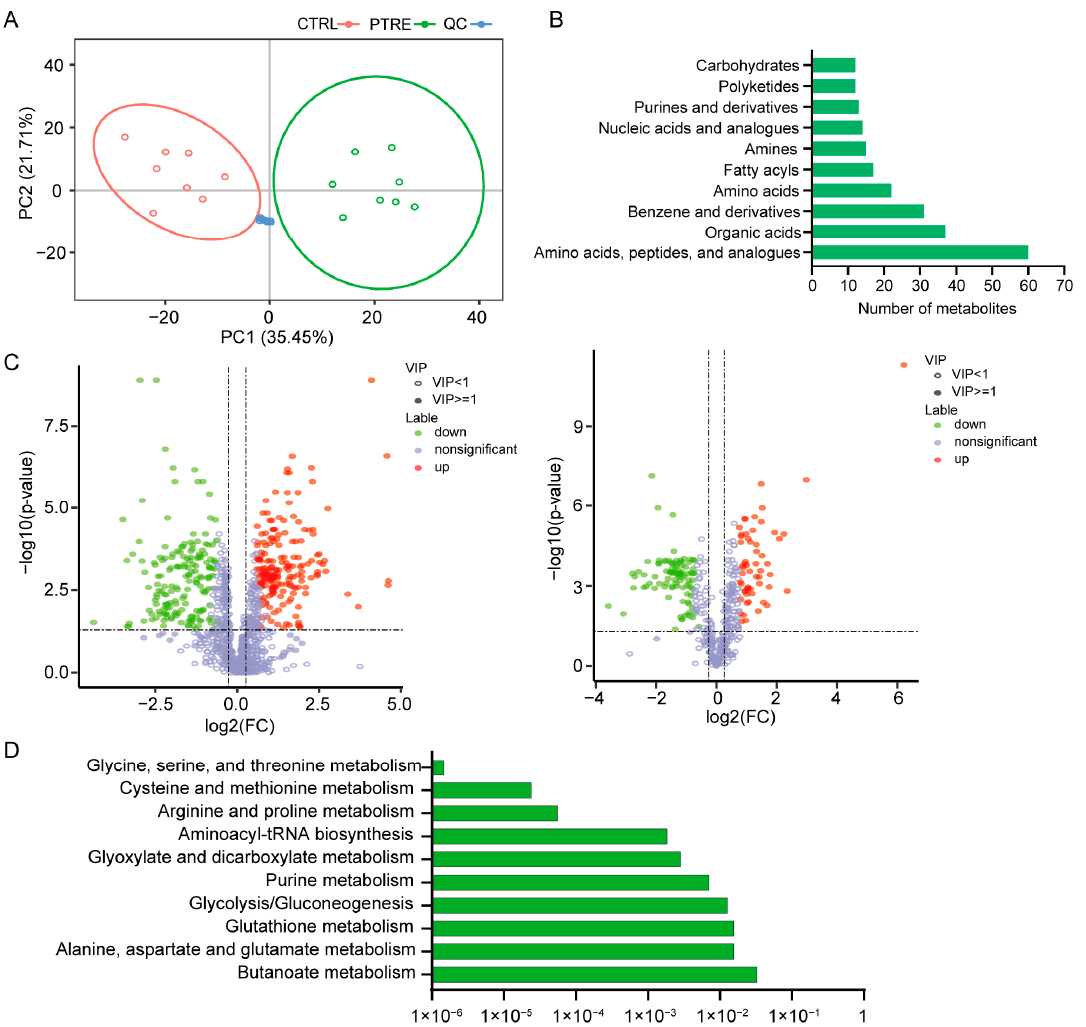
Figure 1. Metabolic changes in cells infected with PEDV. ( A ) Principal component analysis of PEDV- infected and uninfected cell samples. PTRE: PEDV-infected samples; CTRL: uninfected samples; QC: quality control samples. ( B ) Classification of the identified metabolites. ( C ) Volcano plots of differential metabolites in positive (left panel) and negative (right panel) modes between the PEDV- infected and uninfected groups. The red and green dots represent the upregulated and downregulated metabolites. ( D ) Metabolic pathways enriched by the differential metabolites.